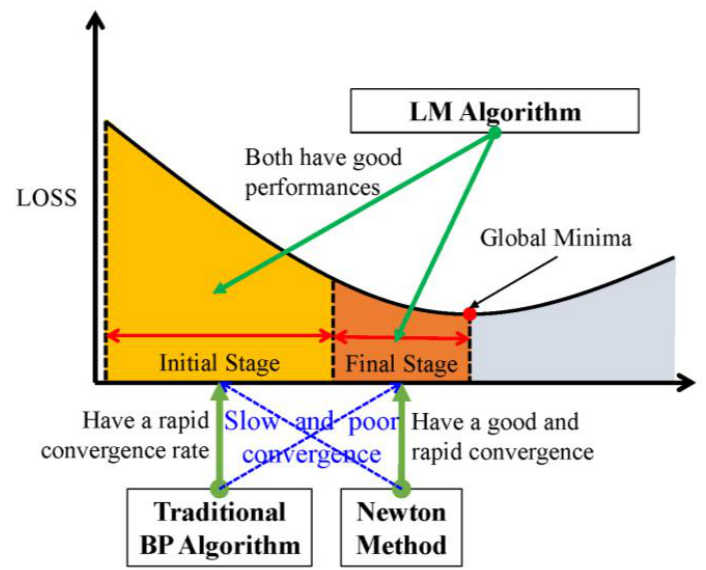
Figure 9. Three different algorithms’ performance in the loss function.